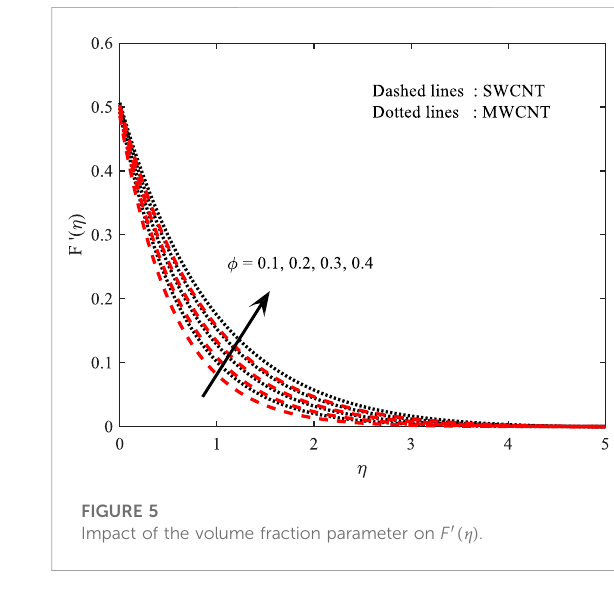
FIGURE 3 Impact of γ on F ′ ( η ) .